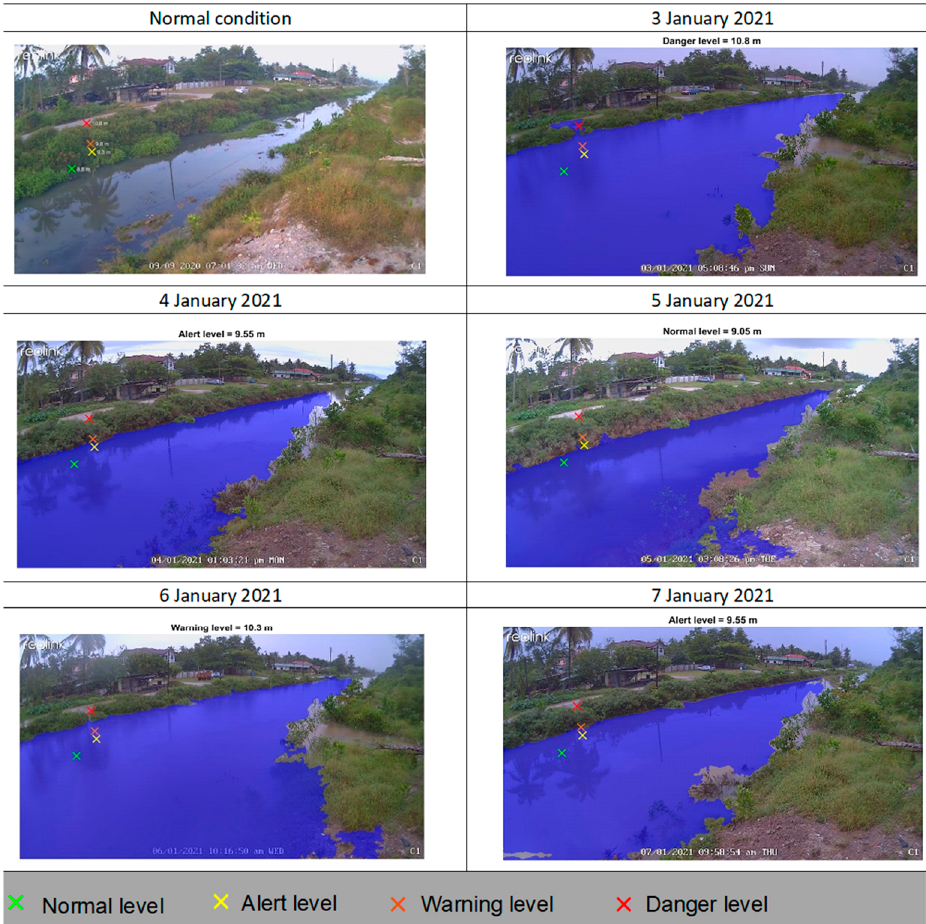
Figure 15. The segmentation results were overlaid with the water level thresholds extracted from LiDAR data to give clear visualization on the rising and falling of water levels during the wet condition. The green marker represents the normal level, the yellow marker represents the alert level, the orange level indicates the warning level and the red marker indicates the danger